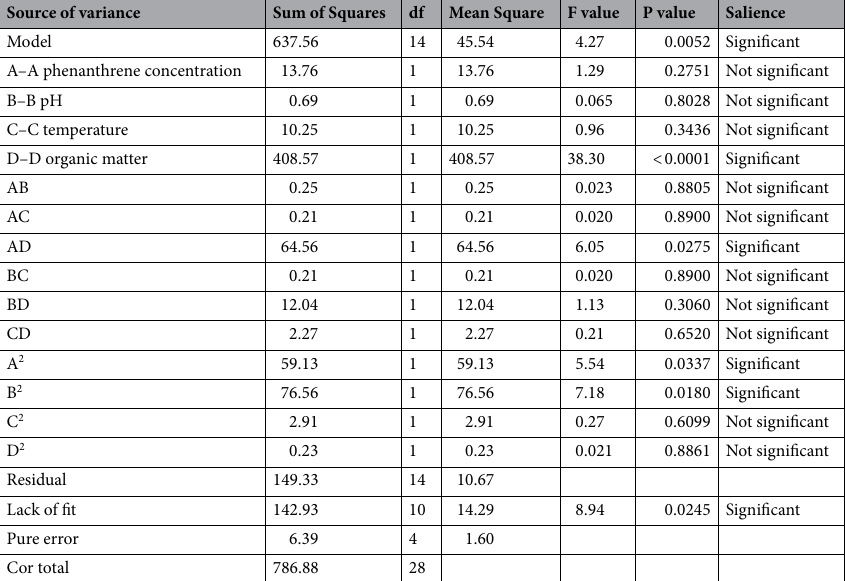
Table 7. Variance analysis results of loess optimization